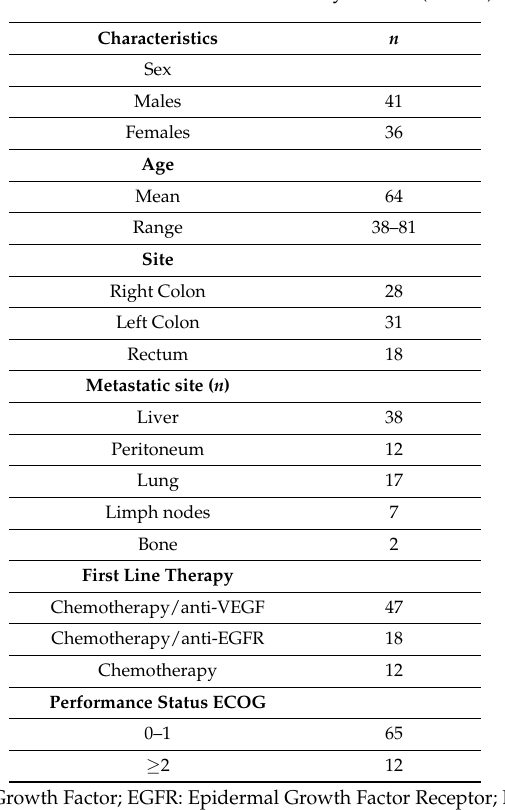
Table 1. Characteristics of the study cohort ( n =